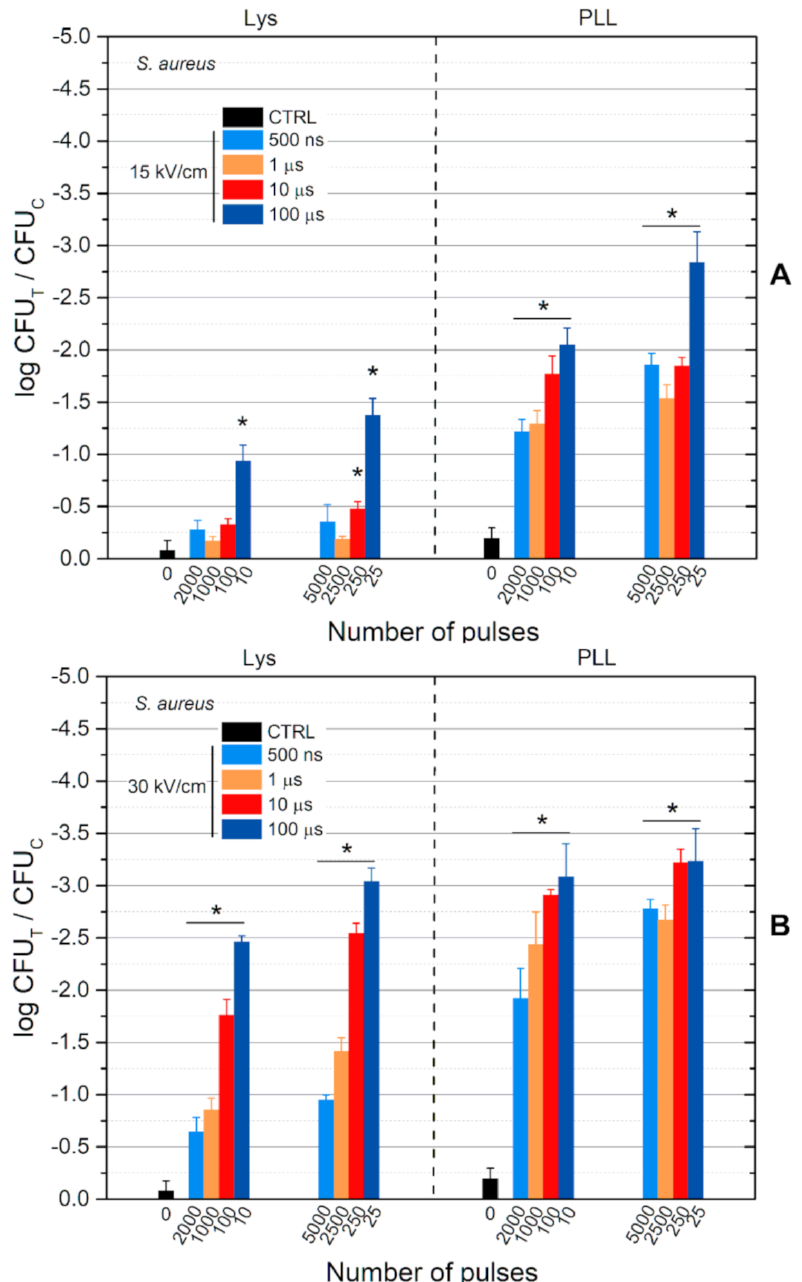
Figure 4. The antimicrobial efficacy of L-lysine and poly-L-lysine with pulsed electric field treatment against S. aureus , where ( A ) 15 kV/cm treatment; ( B ) 30 kV/cm treatment. Asterisk (*) represents statistically significant ( p < 0.05) difference versus Lys or PLL treatment, respectively. CTRL—samples with Lys or PLL without PEF